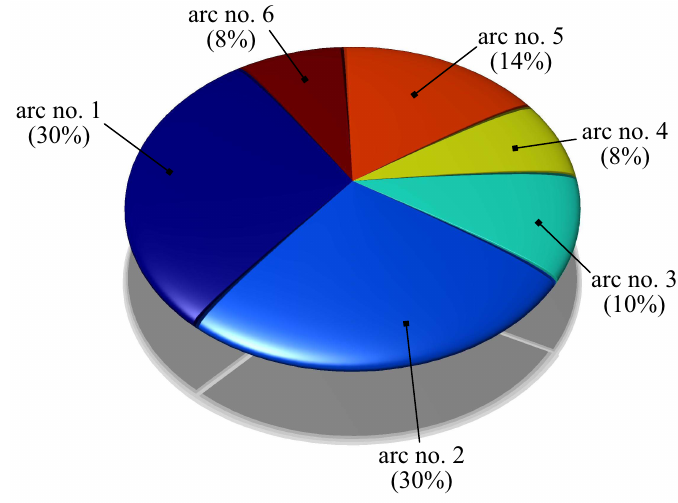
Figure 10. Duration of the generic arc in percentages of the total flight time ∆ t (cid:39)